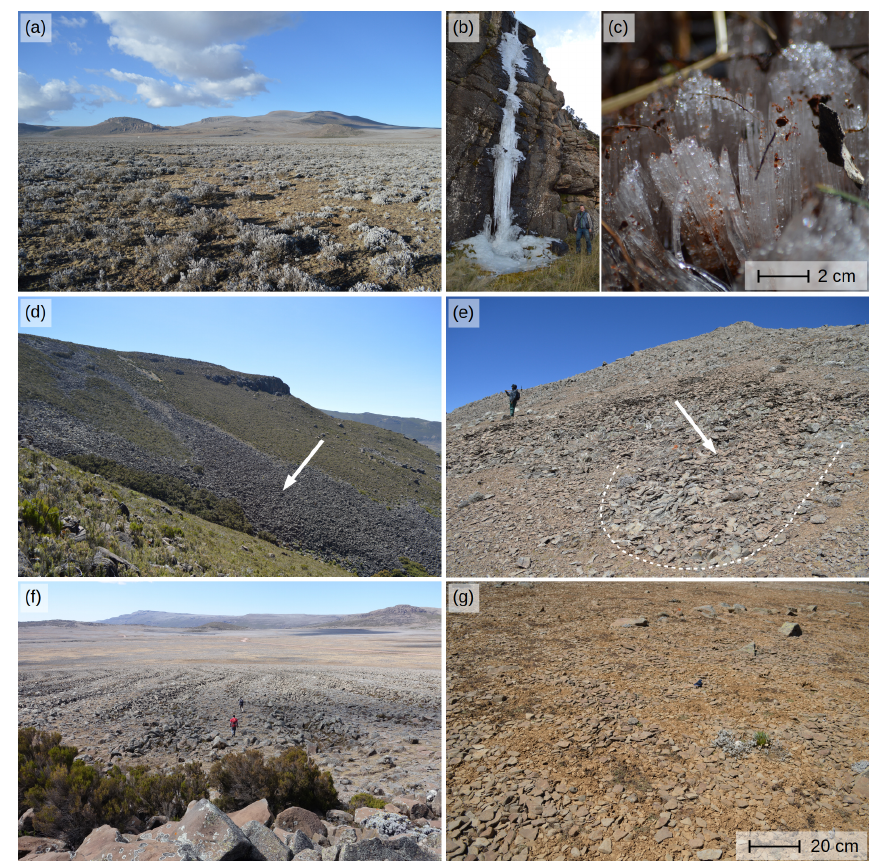
Figure 3. Contemporary frost phenomena and relict periglacial landforms in the Bale Mountains: (a) view from the southern Sanetti Plateau towards Tullu Dimtu, (b) seasonally frozen waterfall in the Wasama Valley, (c) diurnal needle ice in the Wasama Valley, (d) relict blockfields along the southern Harenna Escarpment, (e) active solifluction lobes on Mt. Wasama, (f) relict sorted stone stripes, and (g) active sorted polygons on the Sanetti